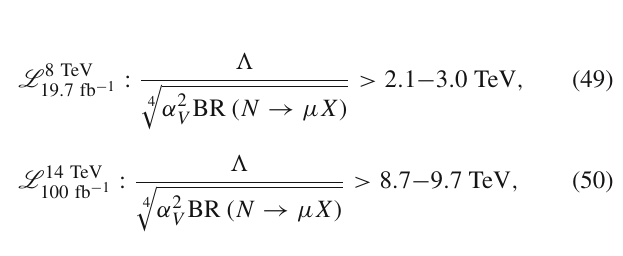
= 1 ) for various collider configura- R √ s ) and integrated luminosity caches ( L